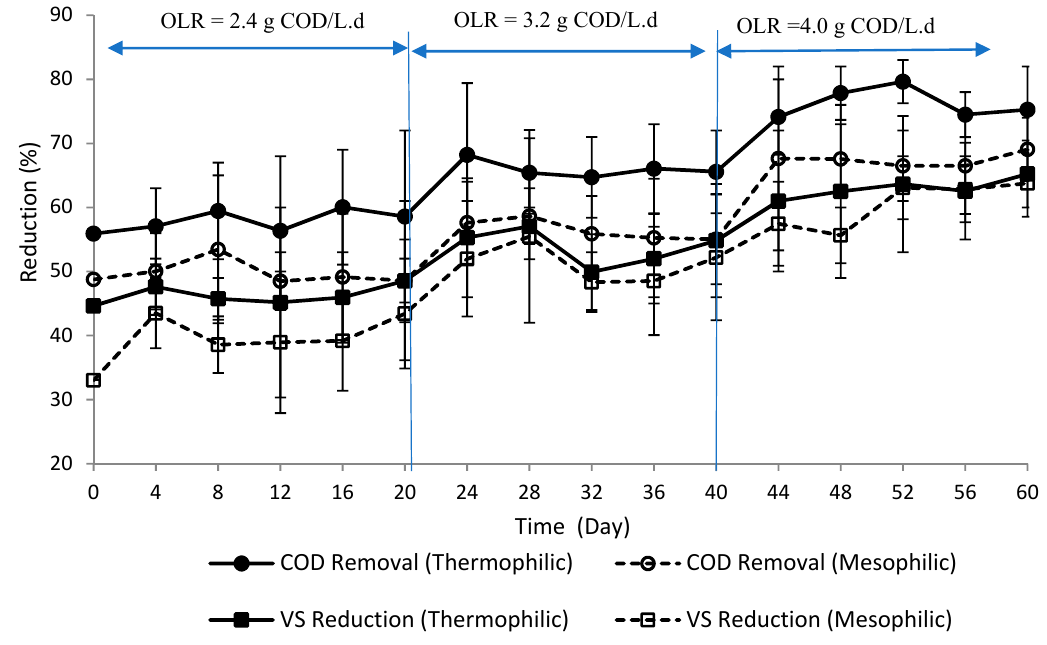
Figure 3. Chemical oxygen demand (COD) removal and volatile solids (VS) reduction at various loading rates. Notes: Error bars show standard deviation of means (n = 3).